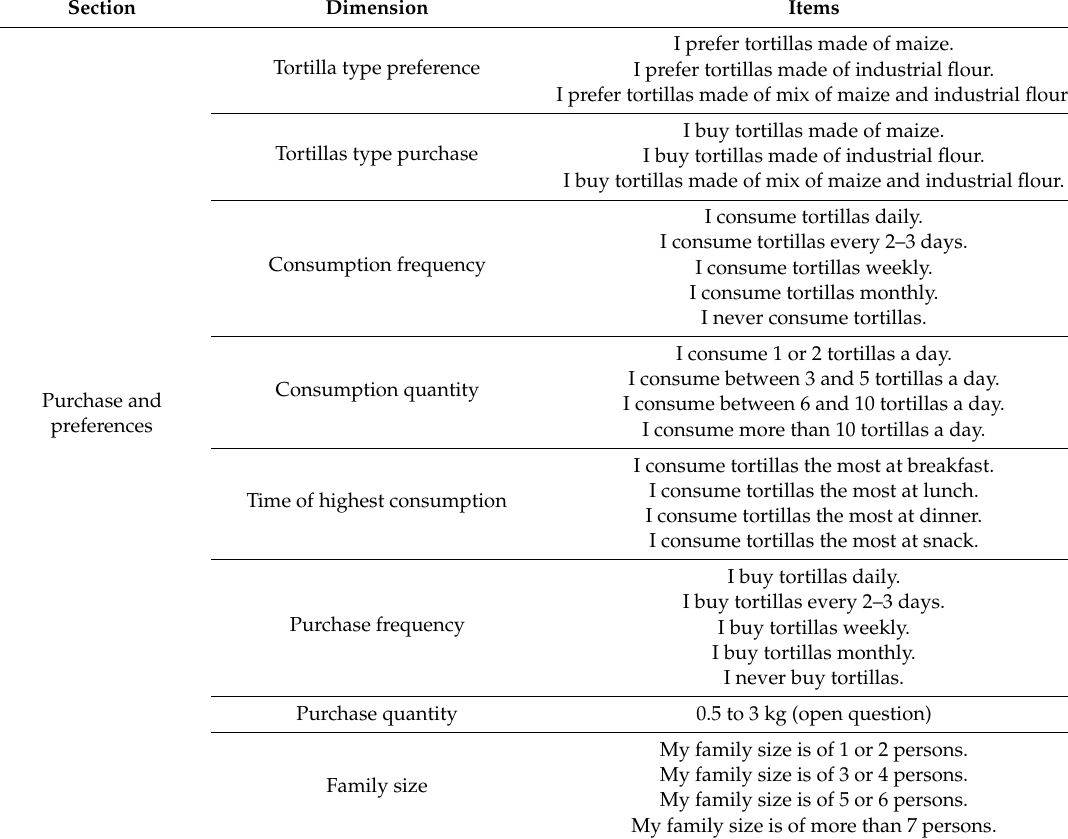
Table 1. Questionnaire items that consumers could